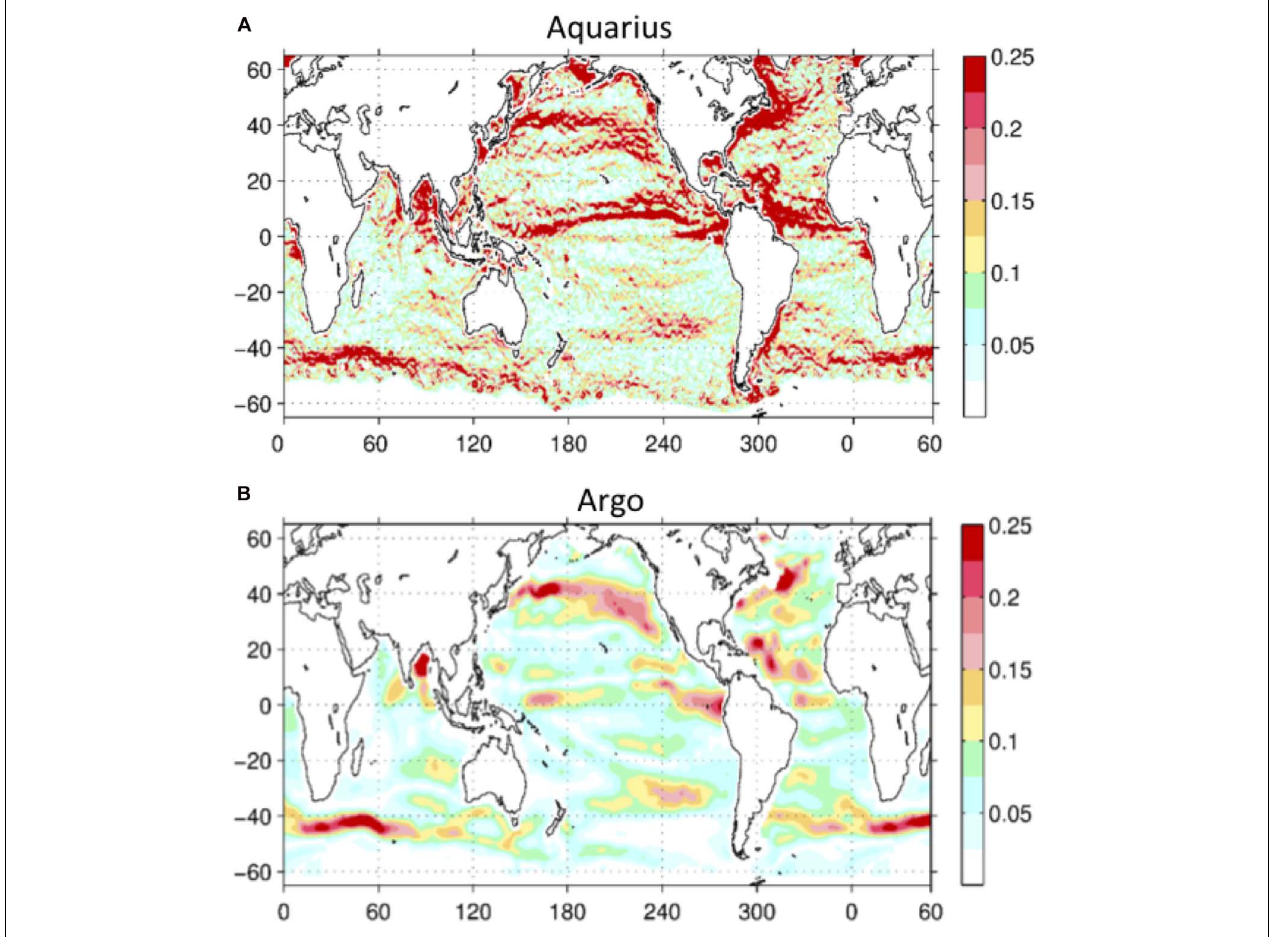
FIGURE 6 | Salinity SSS resolve fine mesoscale features, such as fronts and eddies, that are not depicted by blurry maps computed based in situ-based products; (A) Map of the horizontal SSS gradient magnitude (pss/100 km) based on the September 2011 mean SSS field from the Aquarius satellite. The oceanic frontal zones are associated with high values of SSS gradient (red). (B) The same as in panel (A) but from the Argo-derived SSS. Modified from Melnichenko et al.